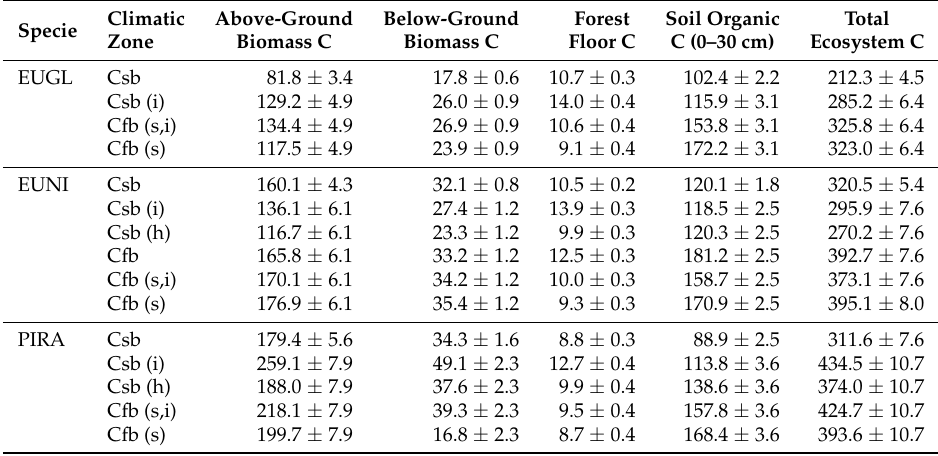
Table A5. Average ( ± standard deviation, n = 11,084) carbon (C) stocks [Mg · ha − 1 ] in each climatic zones for each specie at rotation age (10–14 years-old for EUGL and EUNI, 20–24 years-old for